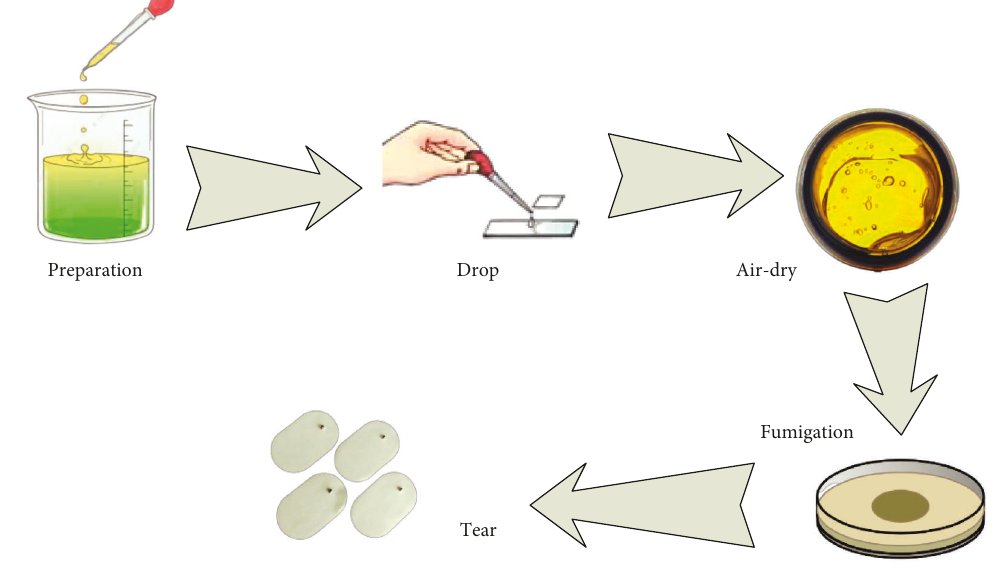
Figure 5: Preparation process of nanoscale flexible composites.